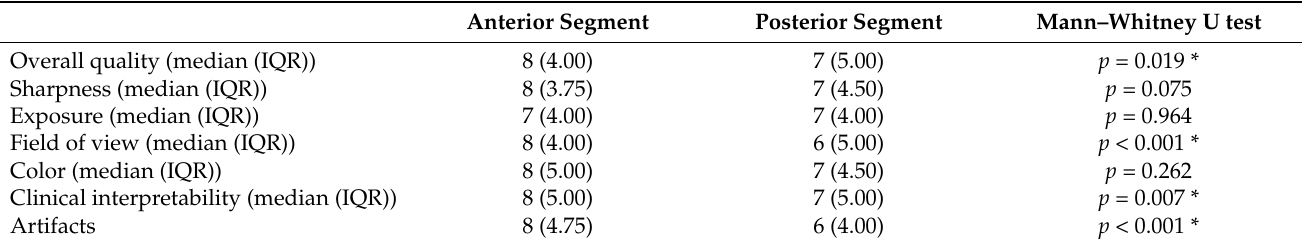
Table 2. Image grading smartphone